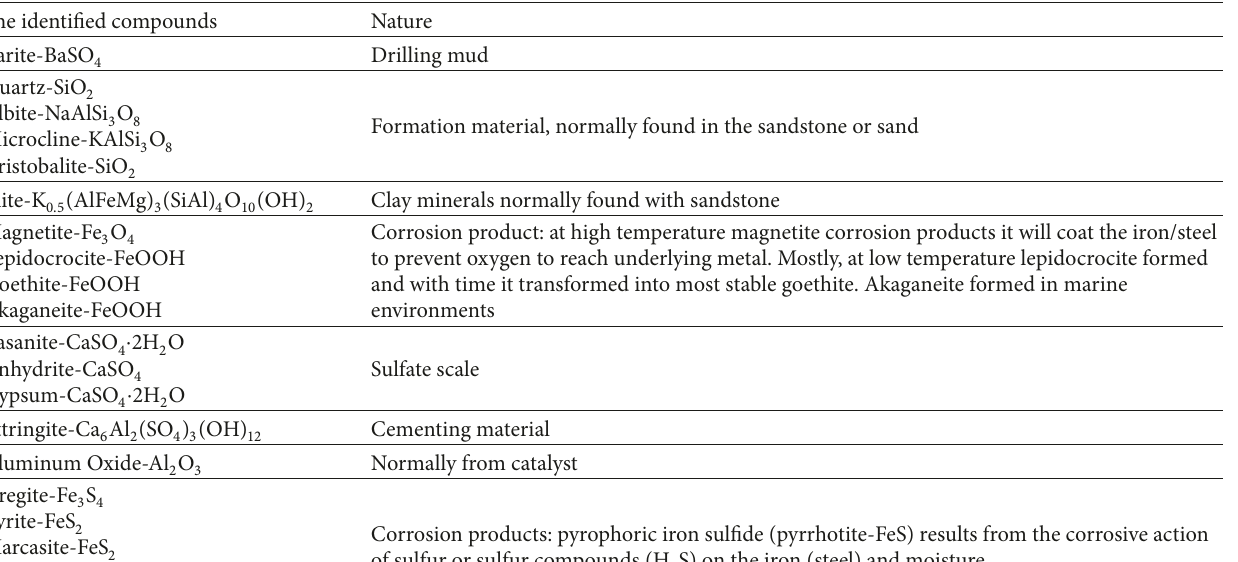
Table 1: Summary of sludge chemical compounds obtained from High Score Plus.